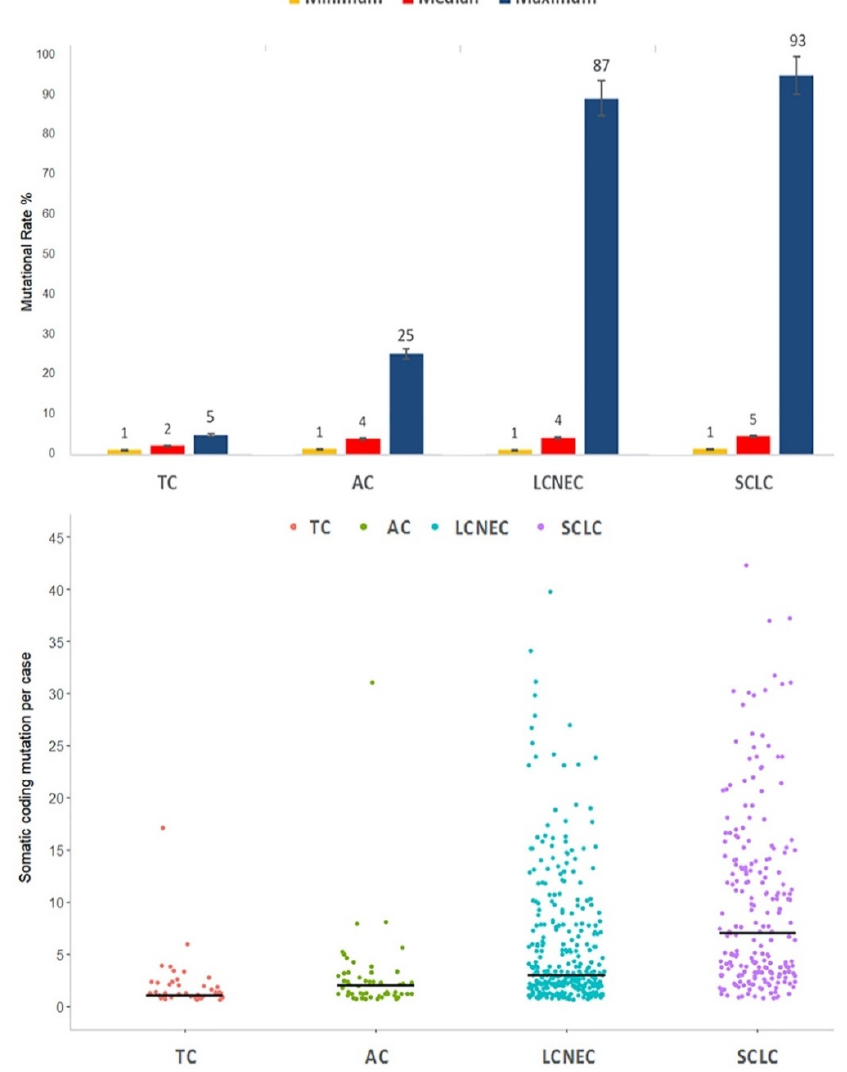
Figure 2. Minimum, median and maximum mutation rate ( above ) and somatic coding mutation per case ( below ) in all four histological variants. Abbreviations: TC, typical carcinoid; AC, atypical carcinoid; LCNEC, large cell neuroendocrine carcinoma; SCLC, small cell lung carcinoma.